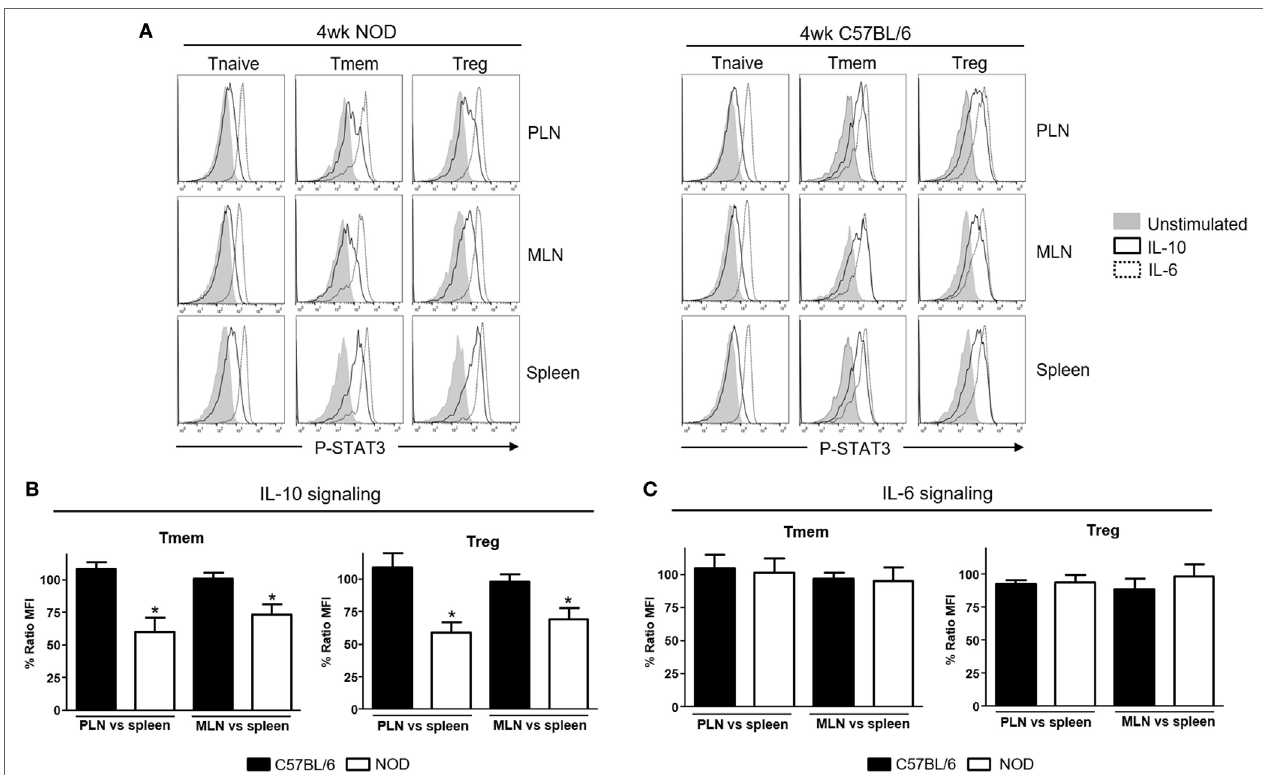
FigUre 1 | Defective interleukin-10 (IL-10) signaling in memory T cells (Tmem) and regulatory T cells (Tregs) in pancreatic and mesenteric lymph nodes of nonobese diabetic (NOD) mice. Cells of pancreatic lymph nodes (PLN), mesenteric lymph nodes (MLN), and spleens of 4-week-old NOD or C57BL/6 mice were either left untreated or stimulated with IL-10 (40 ng/ml) or IL-6 (40 ng/ml) for 20 min. Phosphorylated-STAT3 (P-STAT3) levels induced in CD4 T cell subpopulations (Tnaive: CD4 + CD44 low Foxp3 − , Tmem: CD4 + CD44 hi Foxp3 − , and Treg: CD4 + Foxp3 + ) were measured by Phospho-flow. (a) Representative histograms of P-STAT3 levels in the indicated CD4 T cell subpopulations after IL-10 and IL-6 stimulation. (B,c) Cumulative representation of the percentage of P-STAT3 signal induction in PLN/MLN Tmem and Treg after IL-10 (B) or IL-6 (c) stimulation compared to level induced in the splenic populations of the indicated mouse strain. This ratio of mean fluorescence intensities (MFIs) was calculated by comparing the coefficient index of P-STAT3 between two different tissues, considering the levels in spleen as 100% of expression. Data shown in (B,c) are the average from n = 4 mice per strain and are expressed as % of ratio MFI ± SEM, * p < 0.05, Mann–Whitney U